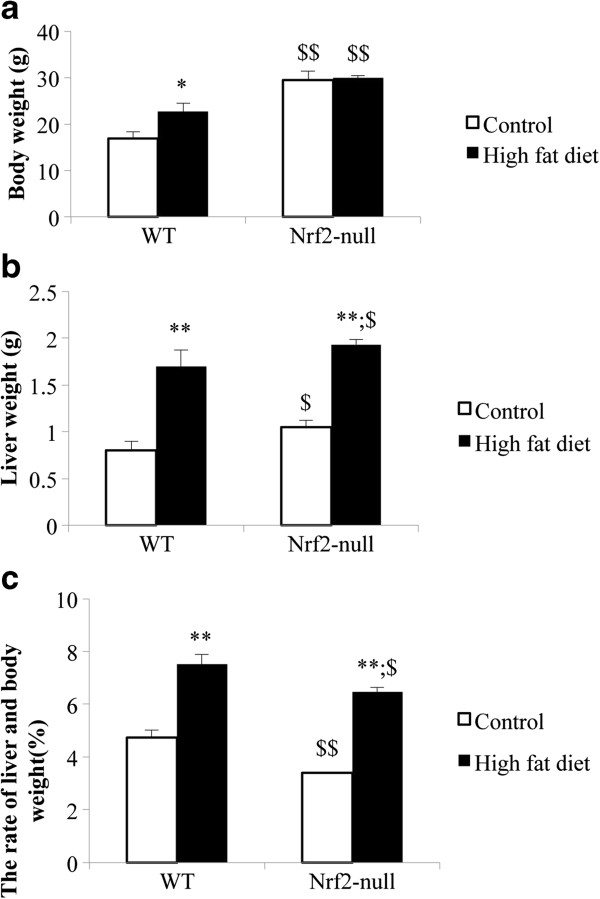
Comparison of Nrf2 with respect to body weight, liver weight, and liver-body. a. The influence of Nrf2 deletion on mice body weight. b. The influence of Nrf2 deletion on mice liver weight. c. The influence of Nrf2 deletion on mice rate of liver and body. Data are expressed as mean ± SD of 5 mice per group. Asterisks * represent statistical difference caused by HFD within WT and null-Nrf2 groups; dollar signs $ represent statistical difference from WT and null-Nrf2 on the same diet. 0.05 < P values < 0.01 (*, $). P values < 0.01 (**, $$). The same illustrations are used in the following figures that are applicable.